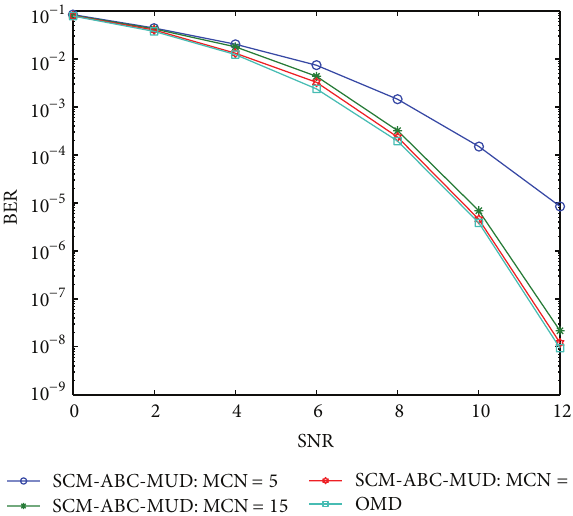
Figure 6: The BER performance with different iteration times of SCM-ABC-MUD.